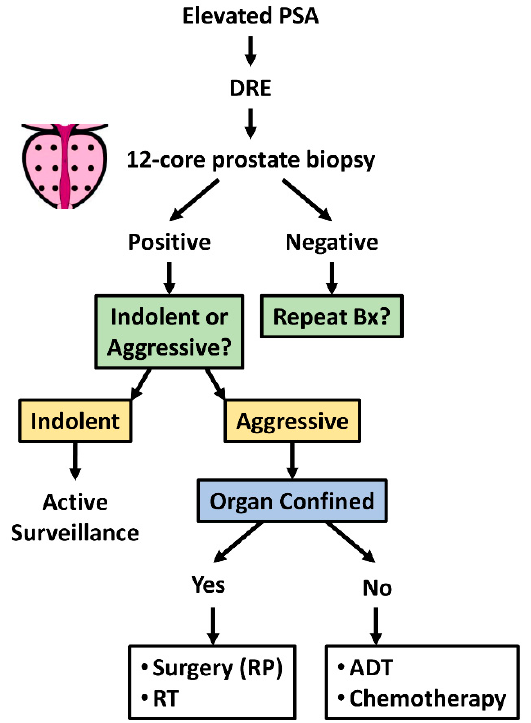
Figure 1. Clinical diagnosis, patient stratification, and treatment options for prostate cancer. Schematic of the clinical diagnosis and patient stratification for appropriate PCa treatment.